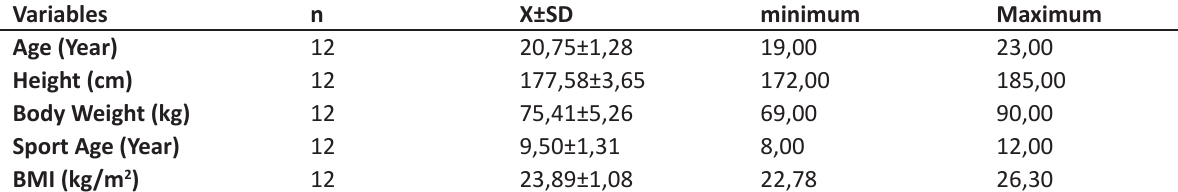
Table 2. The average results of the participants’ selected motoric properties Variables